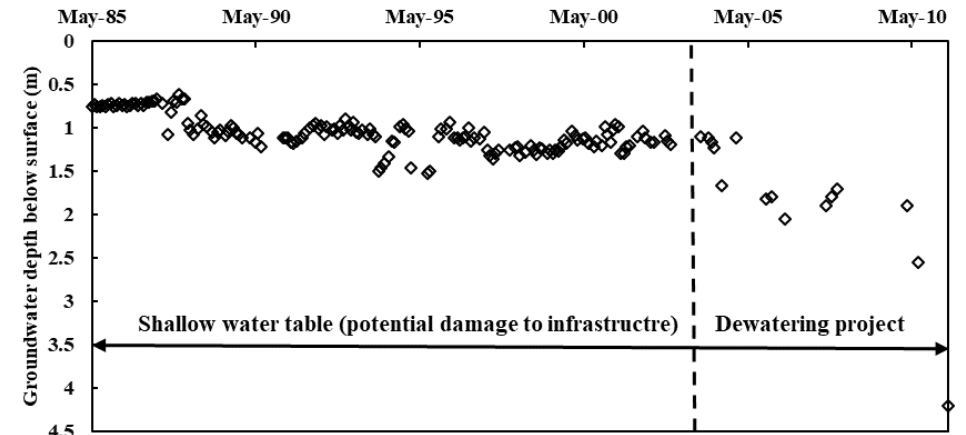
Figure 2. Groundwater levels fluctuation at the DE-1A well.